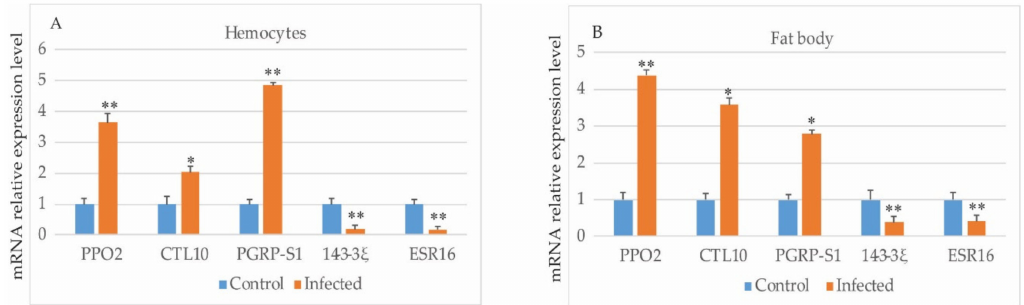
Figure 3. Expression profiles of five genes in the control and infected ( A ) hemocytes and ( B ) fat bodies collected from day-1 female silkworm pupae: For each gene, the transcriptional level of the control was set to 1. The data are the means ± SD of three independent experiments. Statistical analysis was performed using SPSS software. * p < 0.05, ** p <